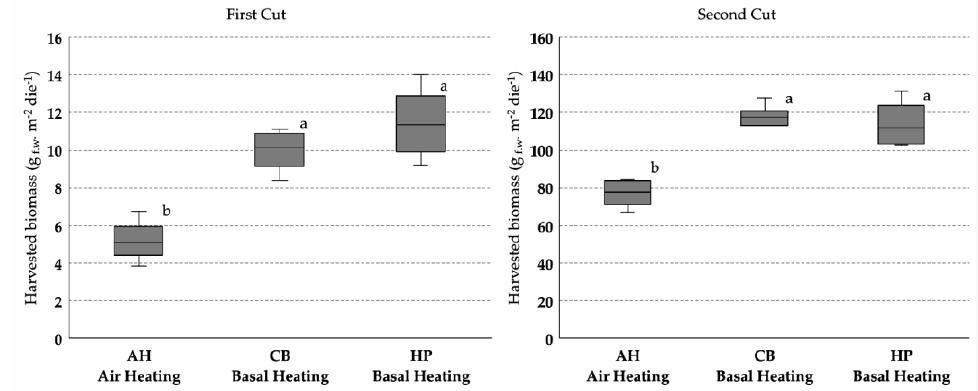
Figure 11. Boxplots representing the daily growth rate of the basil seedlings in the first and in the second growing period for each heating technologies. Means that do not share a letter are significantly different.